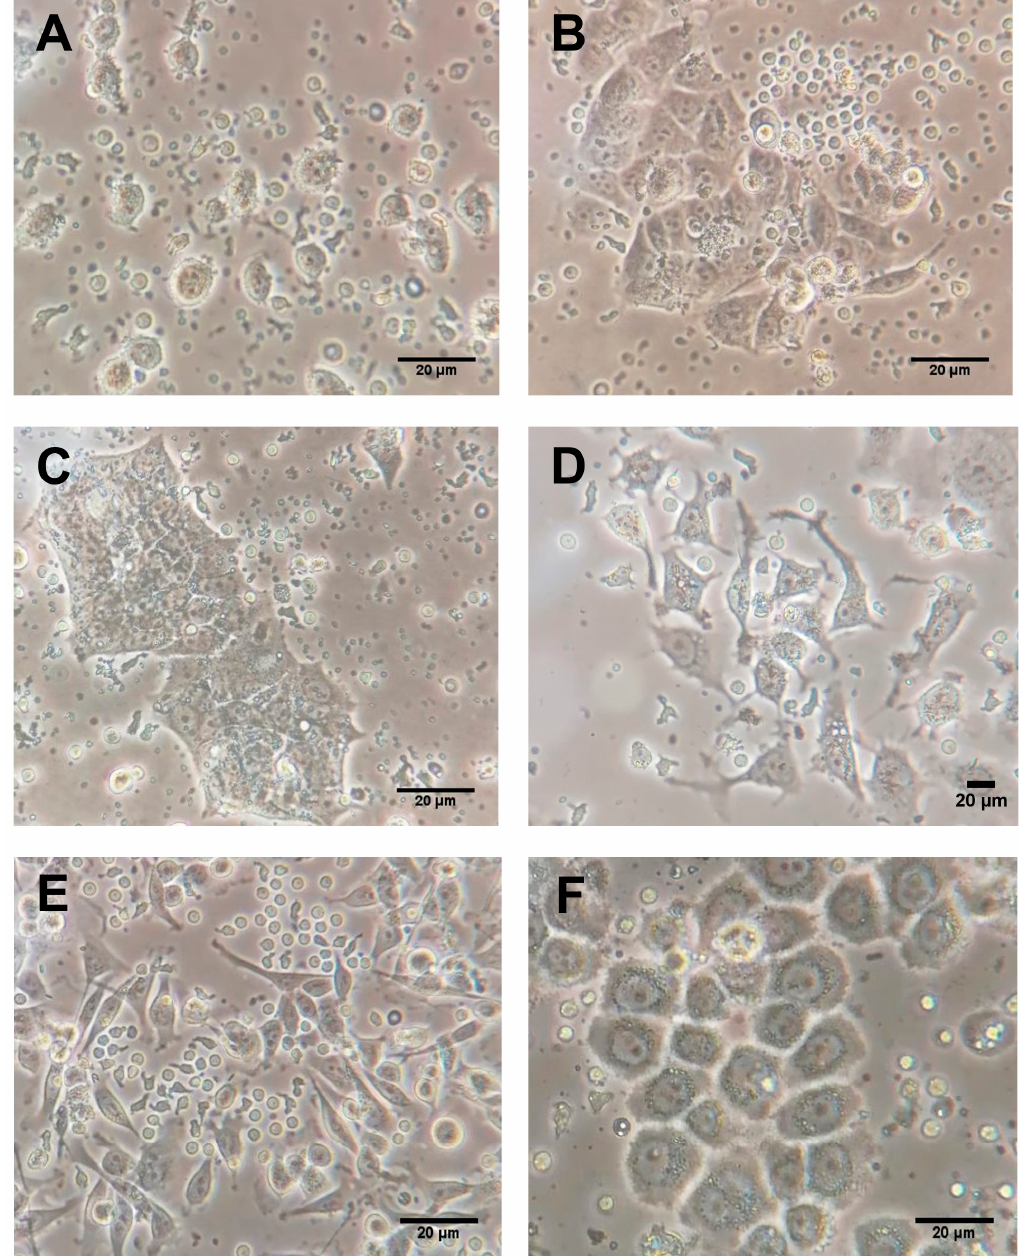
Figure 5. Co-cultures of breast cancer cell lines and peripheral blood mononuclear cells (( A ): T-47D; 40×, ( B ): MCF-7; 40×, ( C ): BT-474; 40×, ( D ): SK-BR-3; 40× ( E ): MDA-MB-231; 40×, and ( F ): MDA-MB-468; 40×). Scale bar: 20 μ m.